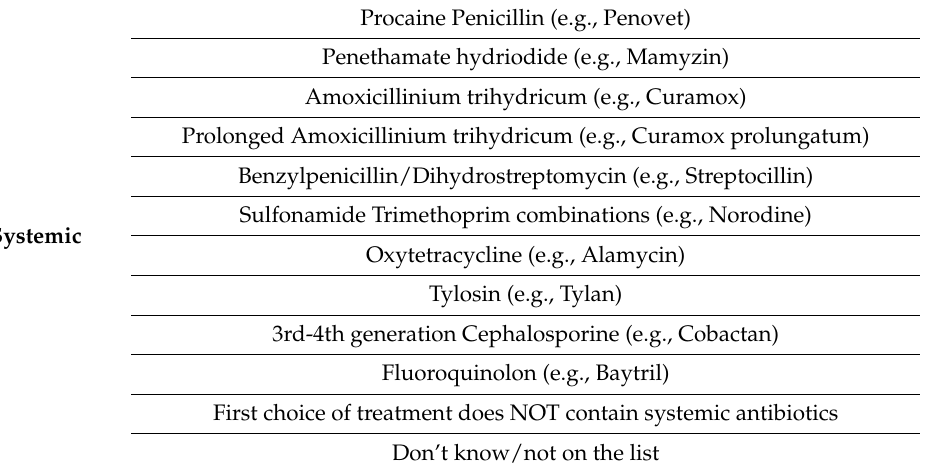
Table A1. A full list of all possible choices in questions about treatment protocol, based on available products on the Danish